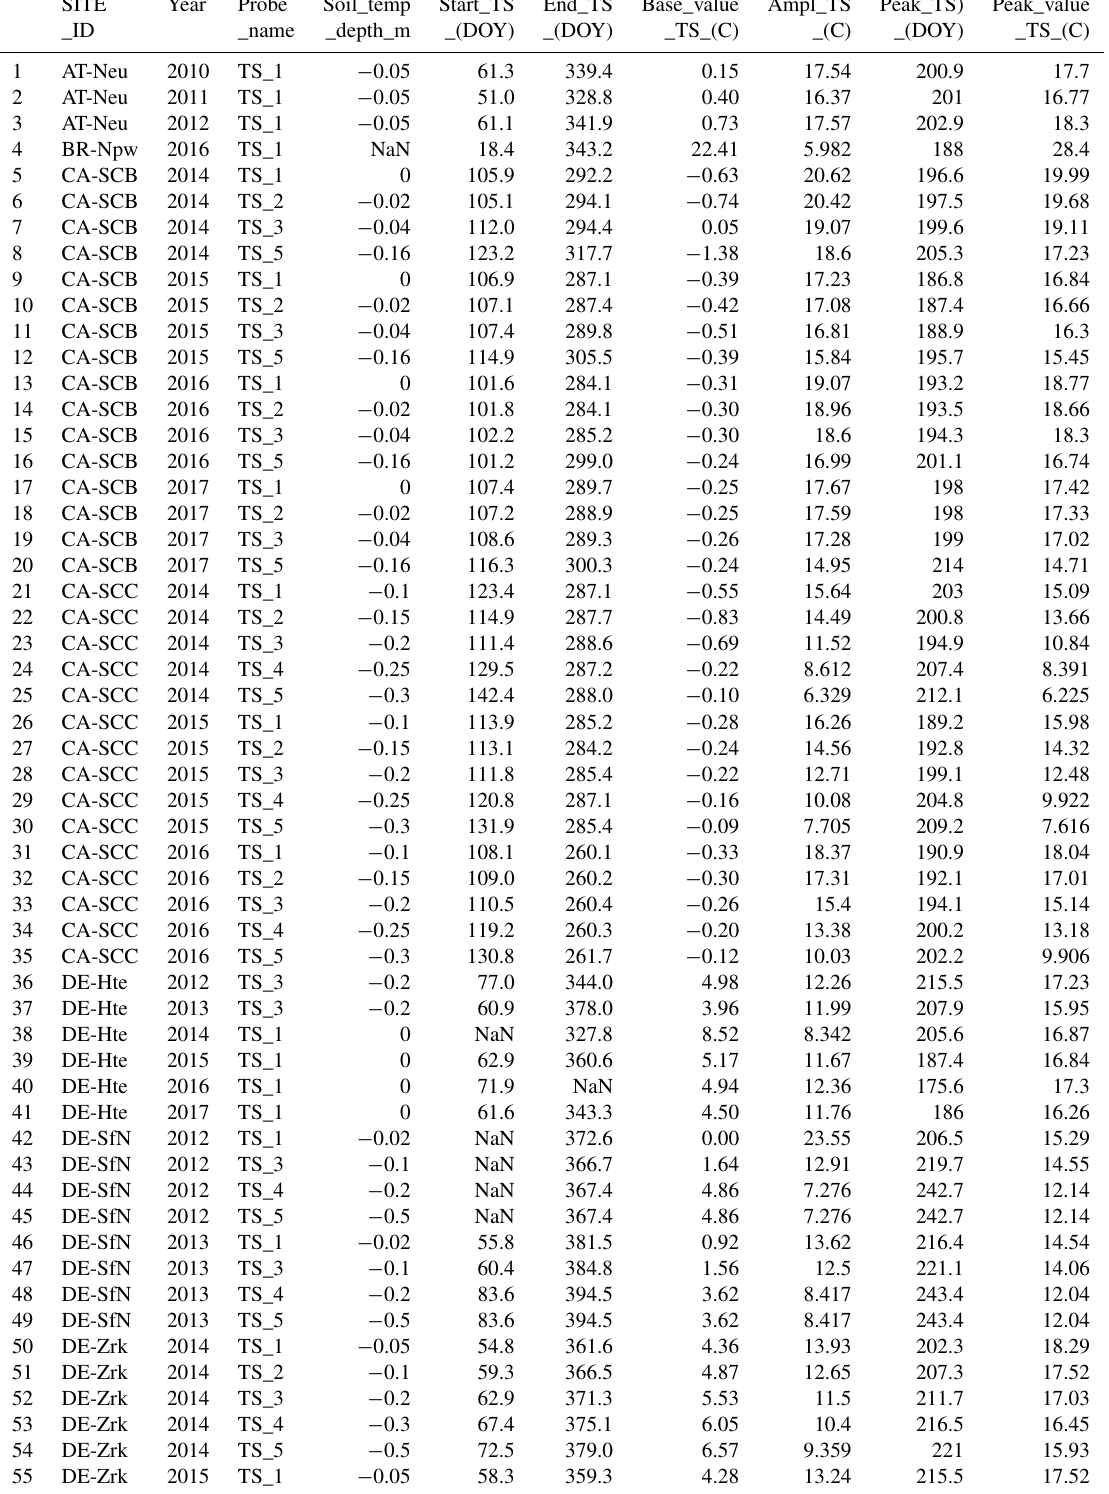
Table B6. Seasonality parameters estimated using TIMESAT software for soil temperature (TS, from every